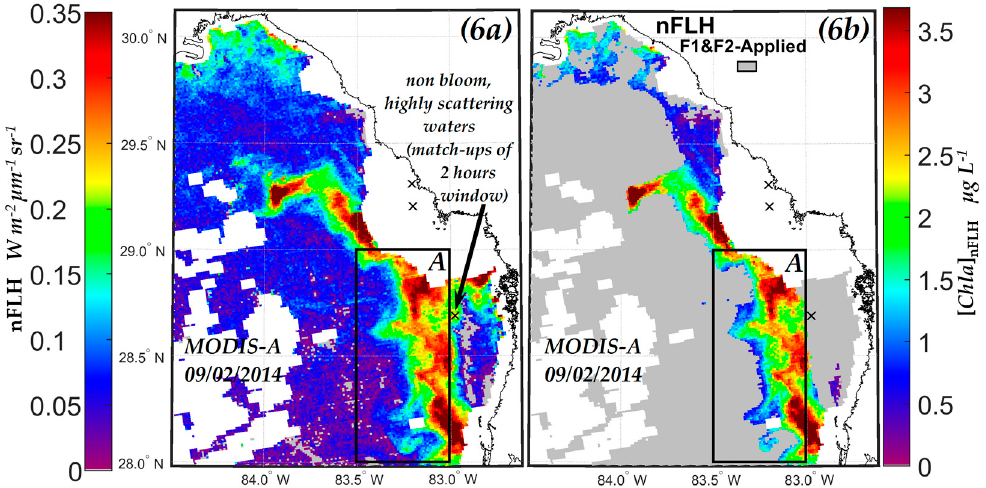
Figure 6. ( a ) MODIS-A nFLH (left hand scale) standard ocean color product, and equiv. [ Chla ] (right hand scale); ( b ) Same image as Figure 6a after filter process masks F1 and F2 are applied. Residual values are therefore compatible with and indicate KB blooms. Notes that “×” symbol in both images indicates no cell counts observed, in situ within 2 h windows from MODIS-A observation. Dark gray represents F1&F2 masks and white represent cloud cover or invalid data.